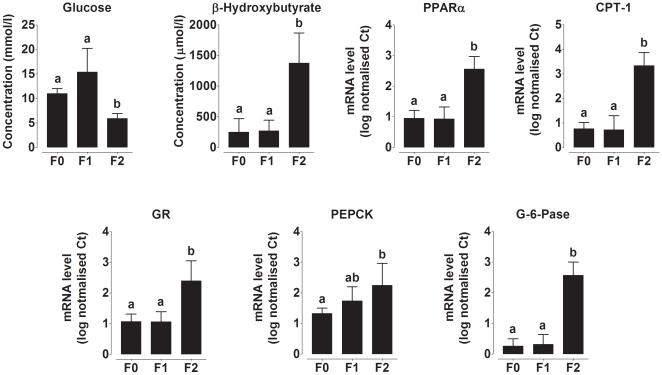
Maternal blood metabolite concentrations and mRNA expression of genes involved in hepatic gluconeogenesis and ketogenesis.Plasma fasting glucose and β-hydroxybutyrate concentrations. Hepatic PPARα, carnitine palmitoyltransferase-1 (CPT-1), glucocorticoid receptor (GR), phosphoenolpyruvate carboxykinase (PEPCK), (G) glucose-6-phosphatase (G-6-Pase) mRNA expression. Values are mean ± SD for n = 5−7 rats per group. Values with different letters are significantly different (P<0.05).